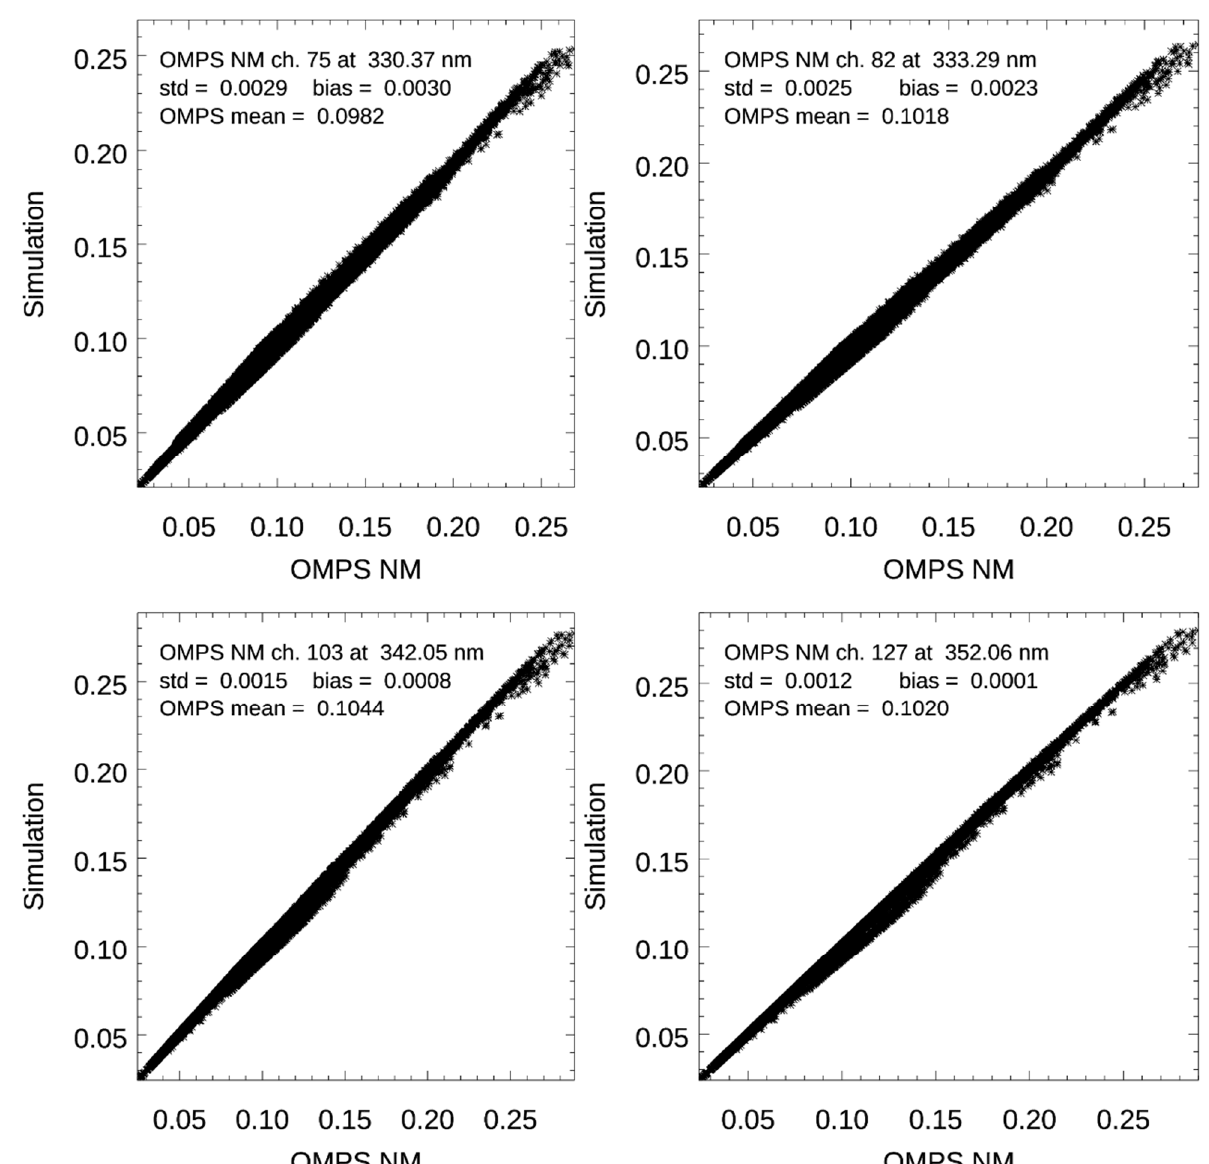
Figure 7. Comparison of the normalized radiance between OMPS NM measurements and the CRTM simulations. The data for solar zenith angles less than 80 degrees are used. The surface reflectance is either interpolated or extrapolated using two reflectance by fitting normalized radiances at 347.6 nm and 371.8 nm.